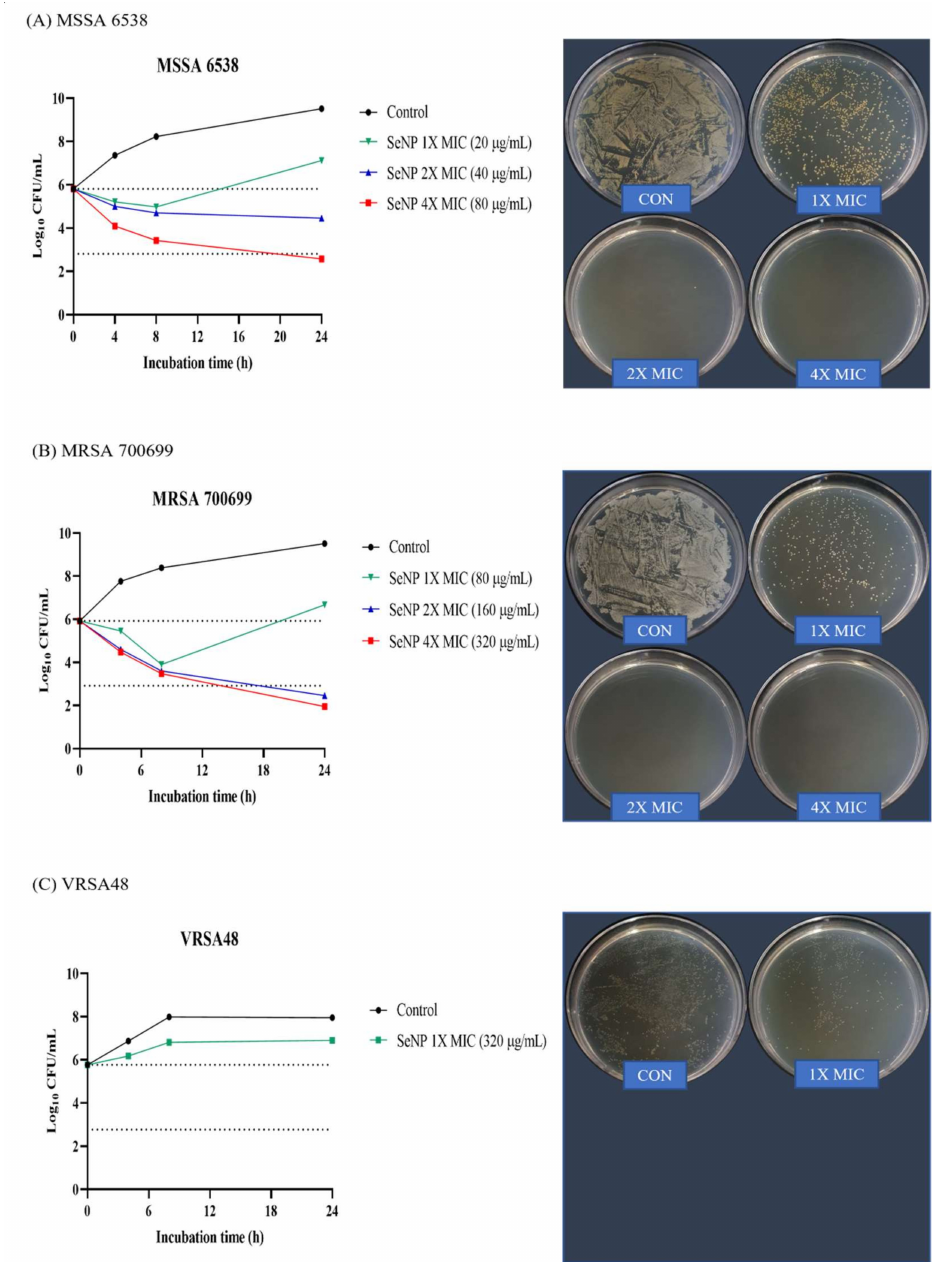
Figure 3. Time-kill assay and CFU check against MSSA, MRSA, and VRSA. ( A ) S. aureus ATCC 6538 (MSSA), ( B ) S. aureus ATCC 700699 (MRSA), and ( C ) VRSA48. Time-kill tests were performed at the concentrations of 1X, 2X, and 4X MIC values of SeNPs for each bacterium. The control was a bacterial solution without any antimicrobial agents. At 0, 4, 8, and 24 h, aliquots (100 µ L) were taken from each group, diluted with PBS, and spread onto MHA plates with 100 µ L of diluted solution to assess the CFU. Plate images were selected as plates capable of showing the first inoculation concentration of 10 5 CFU/mL among spread plates. For MSSA, 4X MIC SeNPs showed bactericidal effects, and 2X MIC SeNPs showed bacteriostatic activity at 24 h. For MRSA, 2X and 4X MIC SeNPs showed bactericidal effects at 24 h. SeNPs at 1X MIC showed minimal antibacterial effects compared to the control against all tested bacteria at 24